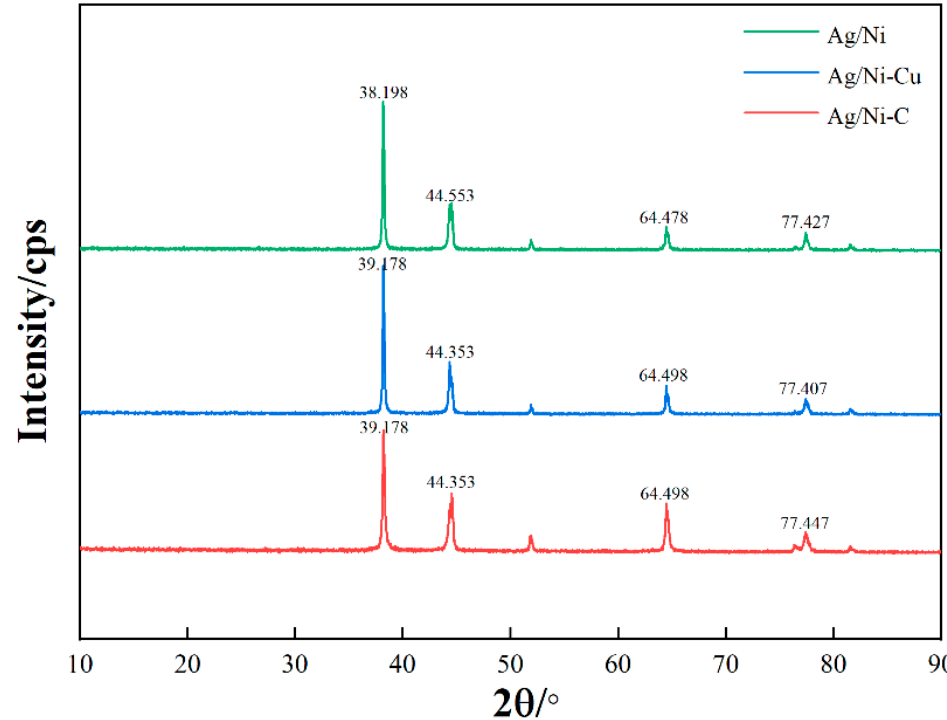
Figure 3. X-ray diffraction pattern.